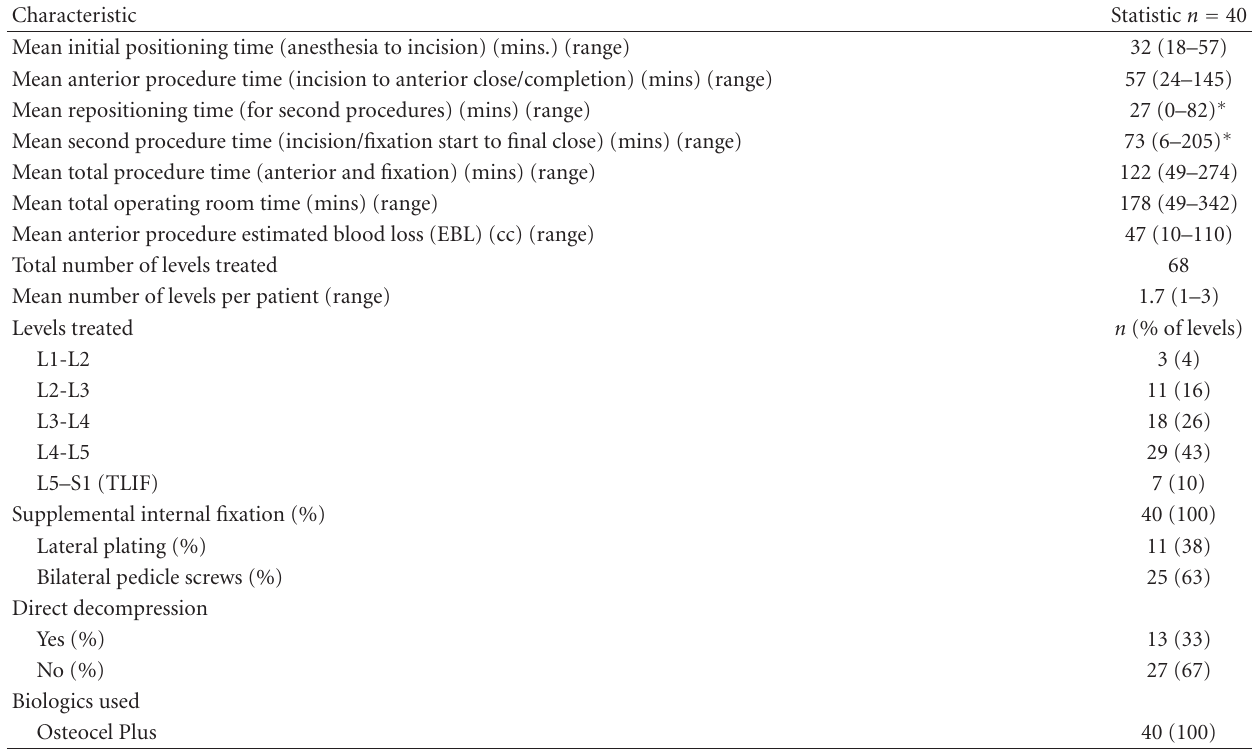
Table 2: Treatment information.